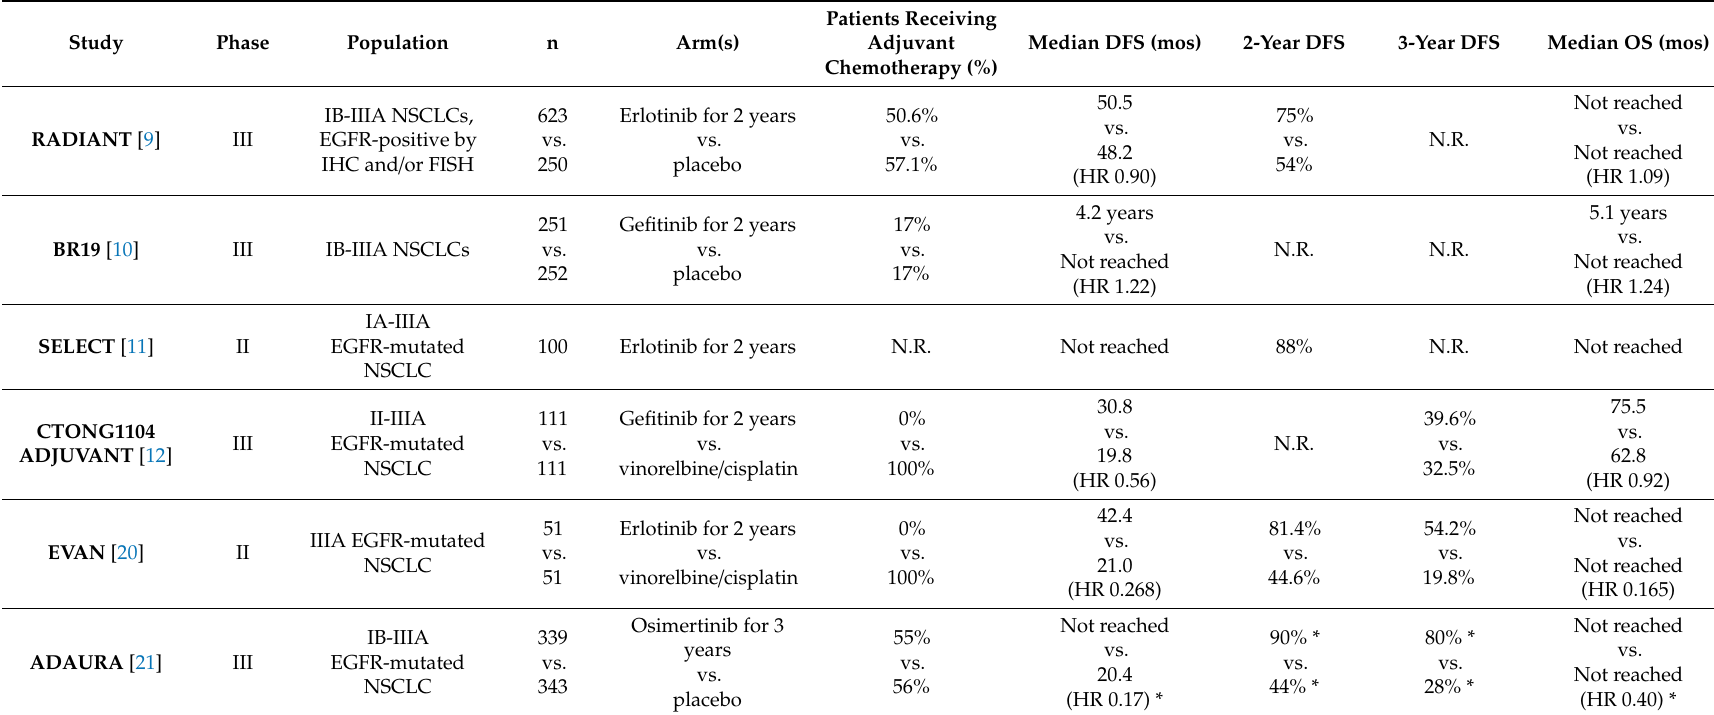
Table 1. Phase II / III studies with EGFR tyrosine kinase inhibitors (TKIs) in the adjuvant